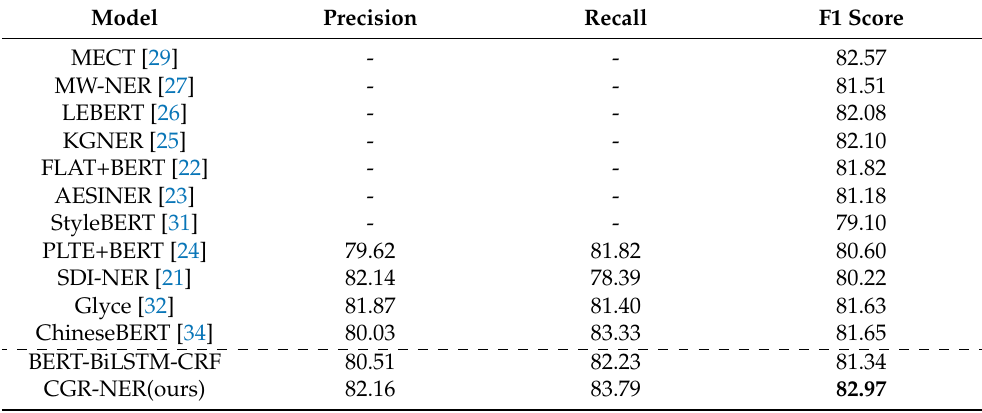
Table 5. Results on OntoNotes 4